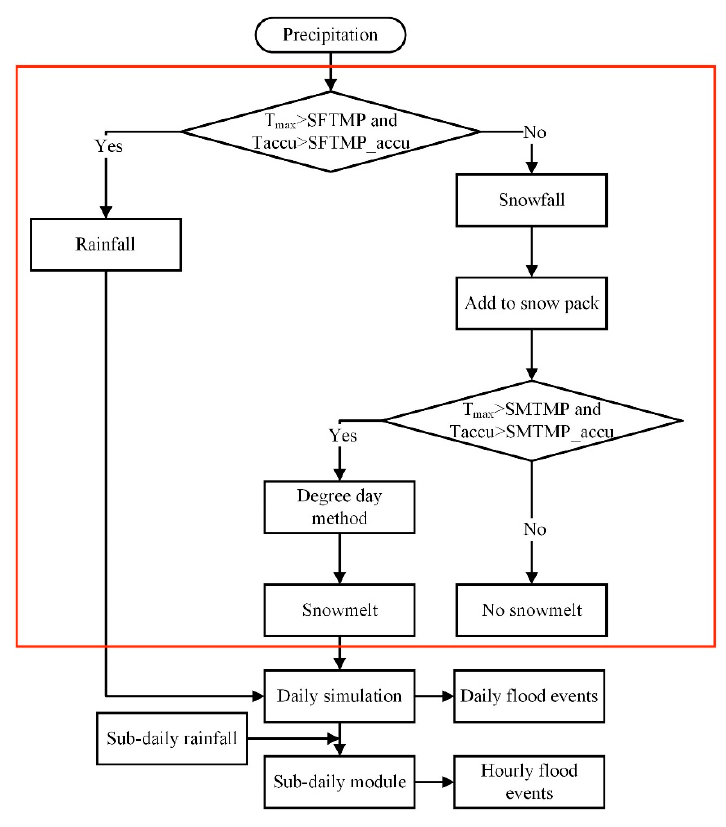
Figure 2. Flowchart of flood process modeling ideas.